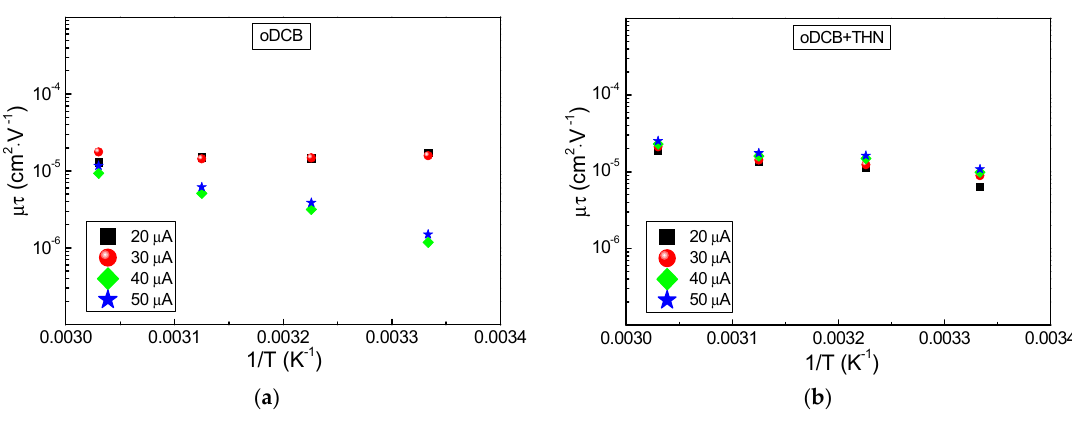
Figure 7. Temperature dependence of the mobility-lifetime products for the blend prepared by using: ( a ) oDCB reference solvent; ( b ) oDCB+THN solvent.